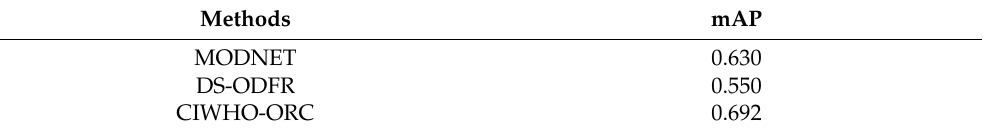
Table 8. Comparative mAP analysis of CIWHO-ORC technique under KITTI MOD dataset.